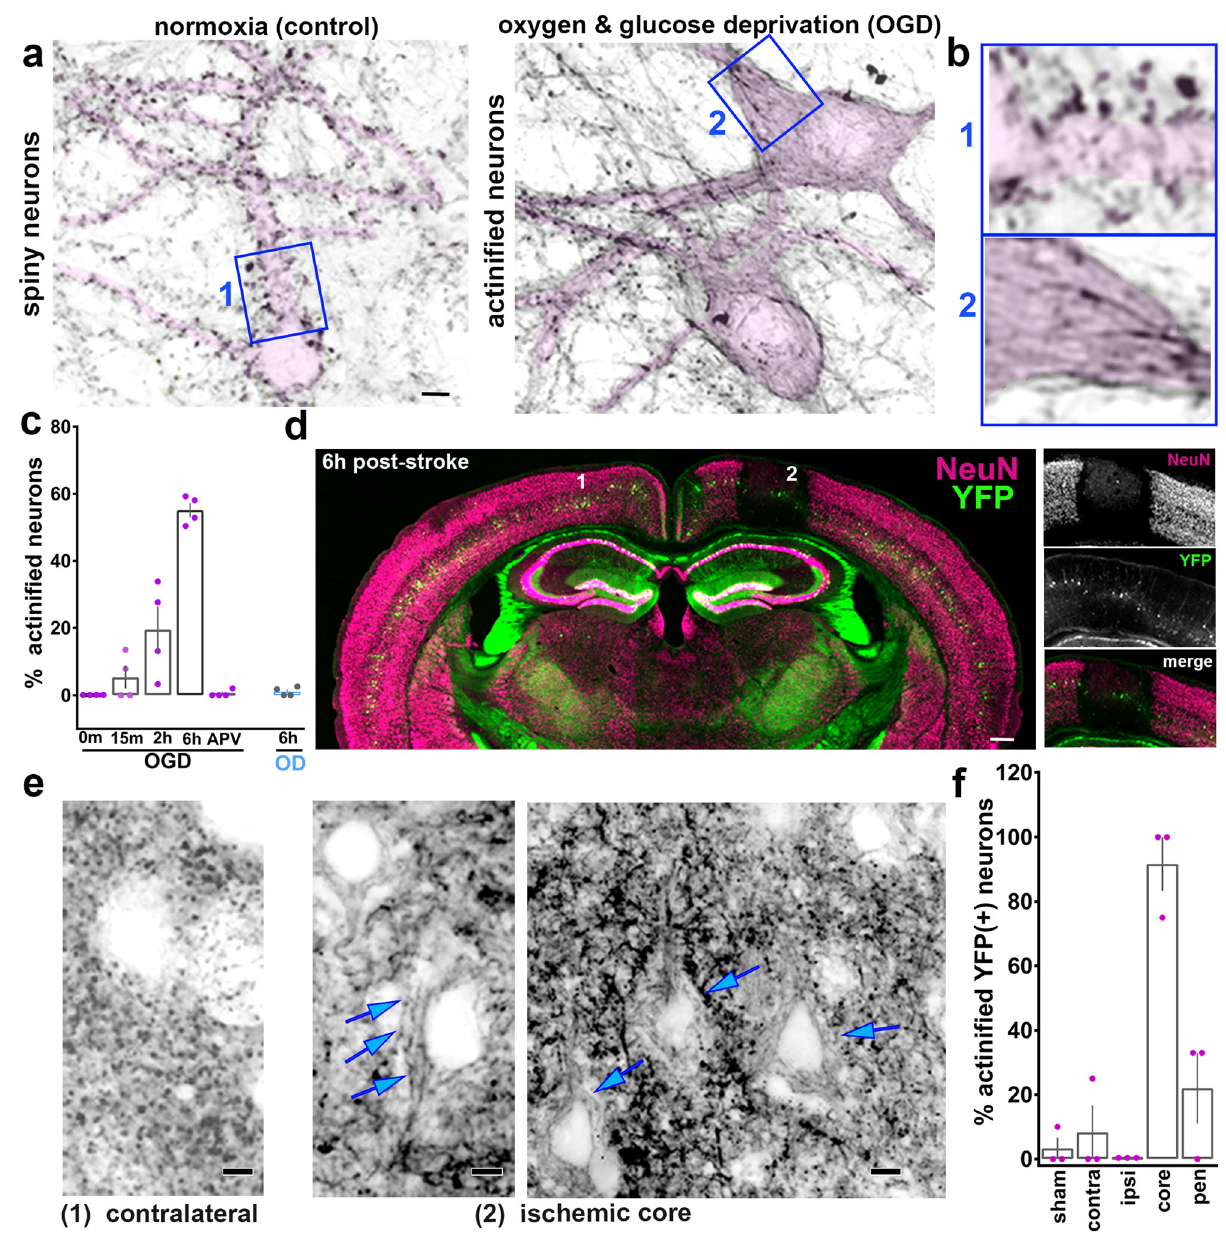
Fig. 1 | Ischemia-induced actin fi lament reorganization. a Cultured rat hippo- campal neurons stained using Alexa-Fluor-647-phalloidin in the absence or pre- sence of oxygen and glucose deprivation (OGD). Selected inverted grayscale somatodendritic regions are highlighted in pink. Note: in control F-actin is con- centrated indendriticspines(dark puncta),while OGD induces a decrease inspine F-actin and an accumulation of linear bundles of F-actin within the soma and dendrite of many neurons (actini fi cation). Scale bar, 5 µ m. b Numbered insets correspond to blue boxed regions in a . Width blue boxes=17 µ m. c Quanti fi cation of the fraction of actini fi ed neurons in control vs OGD or OD (oxygen deprivation) for the indicated durations; the NMDA receptor antagonist APV prevented actini- fi cationseenwith6hOGD. n =4independentexperiments;Kruskal – Wallisone-way ANOVA ( p =0.0066), with Dunn ’ s post hoc multiple comparison analysis ( p =0.0421OGD0mvs6h; p =0.0149OGD6hvsAPV). d Coronalbrainsectionofa Thy1-YFP (green) expressing mouse stained for the neuronal cell body marker NeuN (magenta)6h post stroke. Regions marked “ 1 ” and “ 2 ” : areasfrom which the corresponding enlarged images in e are shown (below). Scale bar, 350 µ m. Right: